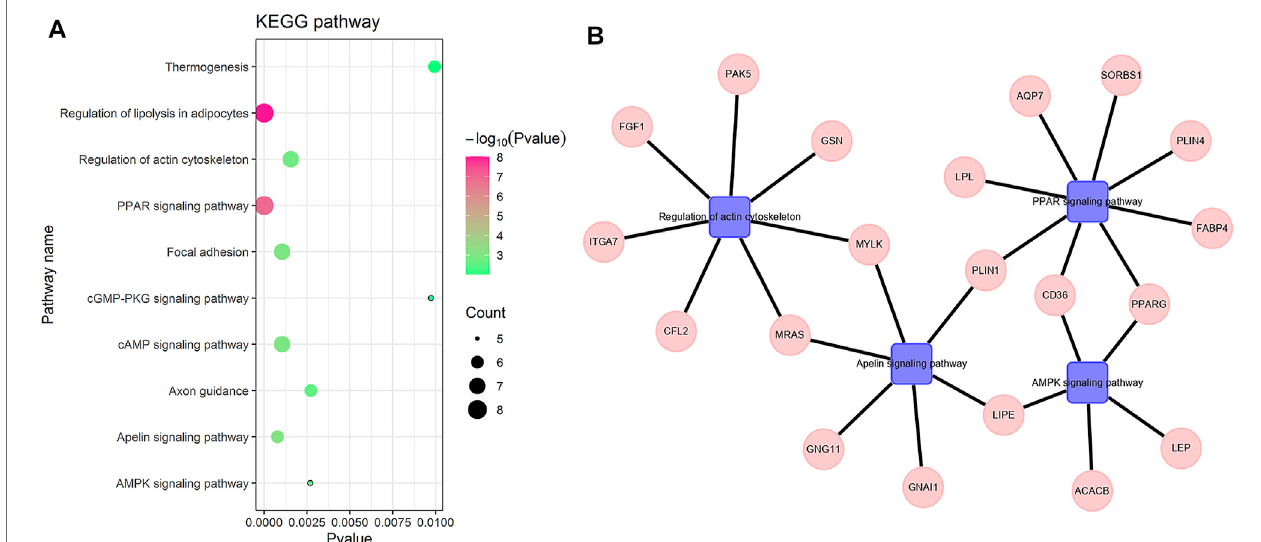
FIGURE 4 | Hub gene-enriched KEGG pathway. (A) is the bubble chart of the hub gene-enriched pathway. (B) is the pathway-enriched gene, the square is the pathway name, and the circle is the gene name.